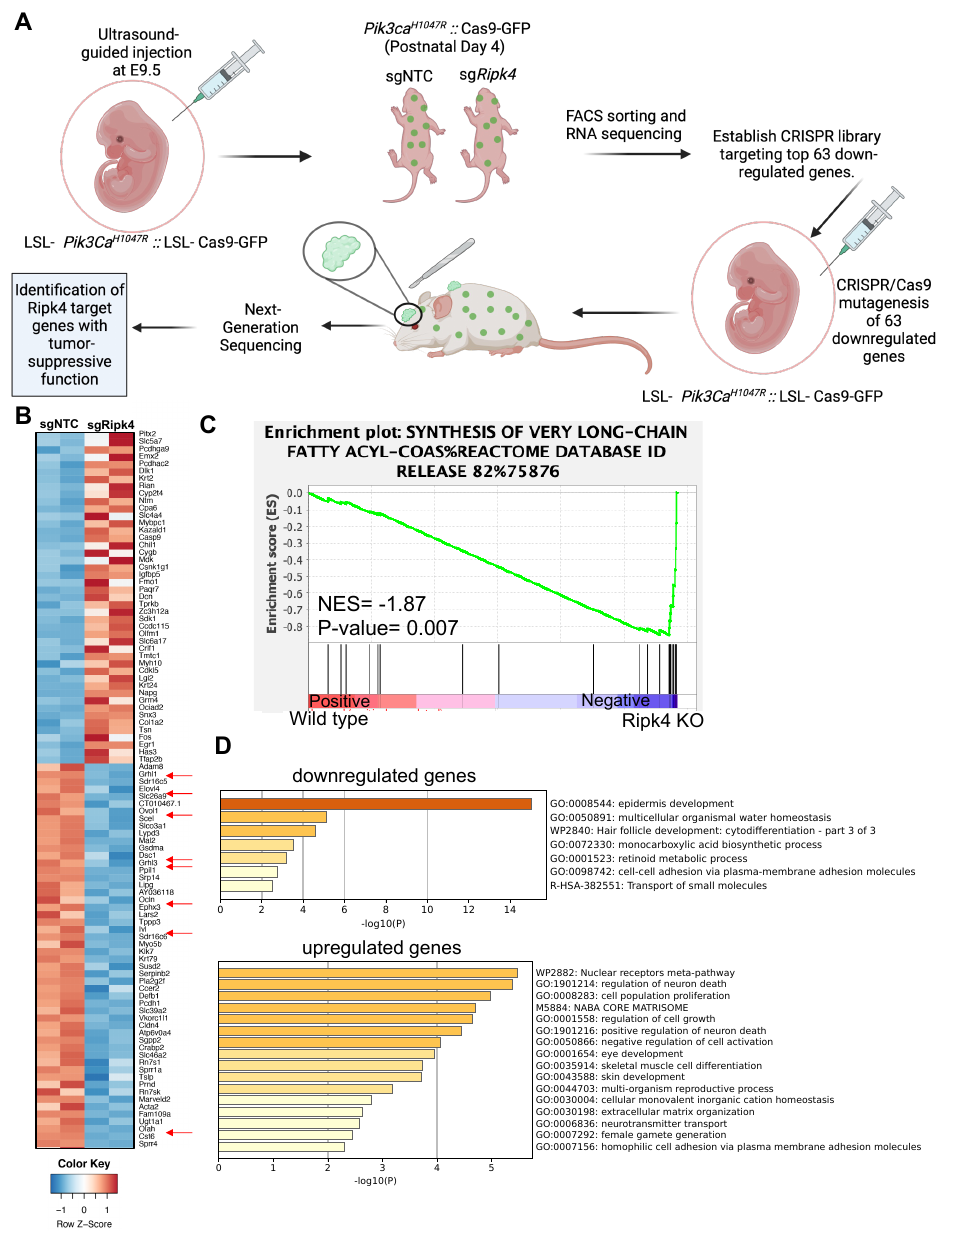
Figure 2. Transcriptome profiling of Ripk4 KO mouse keratinocytes. ( A ) Schematics showing the experimental workflow of RNA sequencing in Ripk4 knock-out keratinocytes and in vivo CRISPR screen of top 63 downregulated genes. LSL-Pik3ca H1047R ; LSL-Cas9-GFP embryonic (E9.5) mice were transduced with sgNTC (non-targeting control) or sgRipk4. At postnatal day P4, the transduced skin was harvested and processed for RNA sequencing. Differential gene expression analysis revealed 63 significantly downregulated genes in Ripk4 KO compared to sgNTC control mice. These 63 genes were selected to construct a targeted CRISPR library and screened in LSL-Pik3ca H1047R ; LSL-Cas9- GFP mice to identify the Ripk4 downstream genes that themselves act as tumor suppressor genes (image created with biorender.com). ( B ) Heat map showing the differential expression of genes in the sgNTC (control) versus sgRipk4 keratinocytes. ( C ) Gene set enrichment analysis (GSEA) revealed downregulation of the synthesis of very-long-chain fatty acids pathway in Pik3ca H1047R ; Ripk4 KO skin. ( D ) METASCAPE pathway analysis revealed several upregulated and downregulated pathways including epidermis